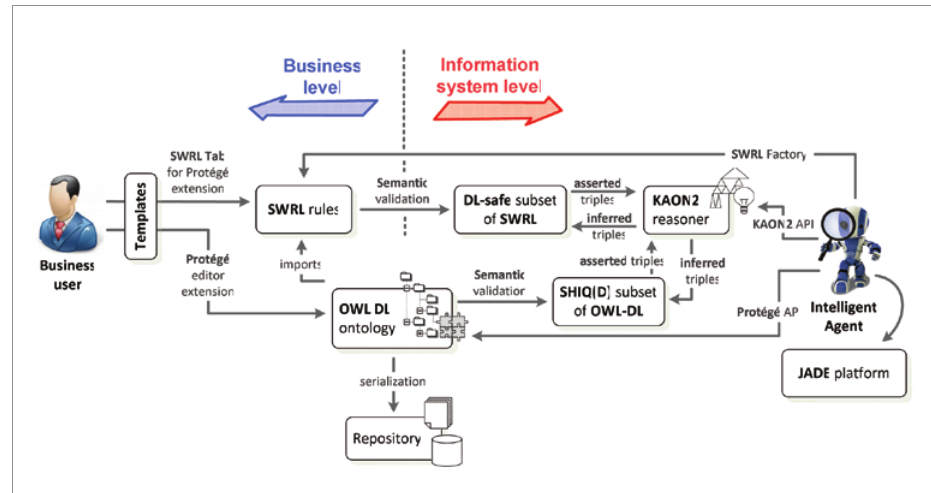
Fig. 3. Prototype of selected case